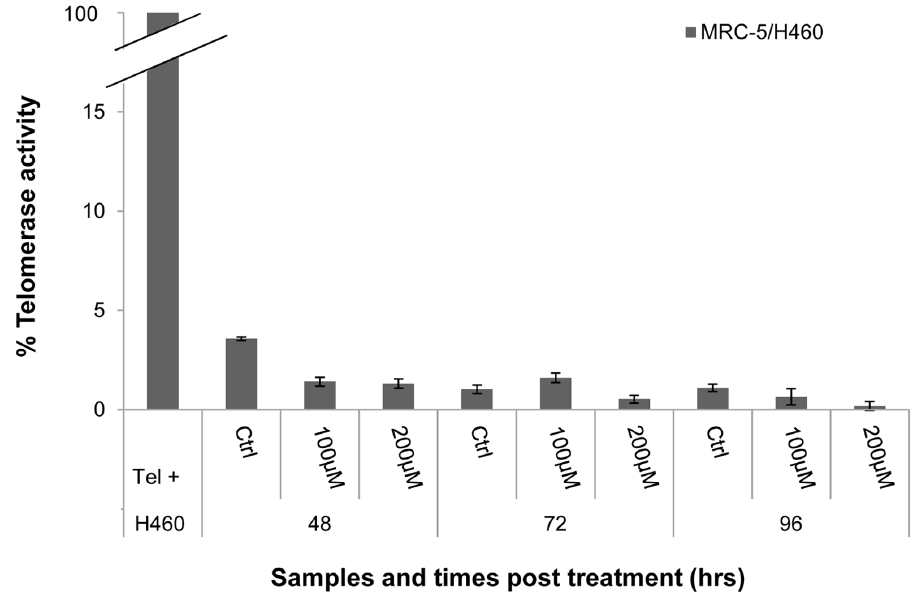
Figure 4. RTQ-PCR TRAP assay. The graph displays data on telomerase activity. Data were normalised to the control value represented by the tumour cell line H460, which is considered to have 100% telomerase activity. Our samples yielded values definitively less than 5%, indicating no telomerase activity in our samples at different doses and times post treatment. The error bars were calculated using standard error propagation rules. p . 0.05 by Student’s t-test.